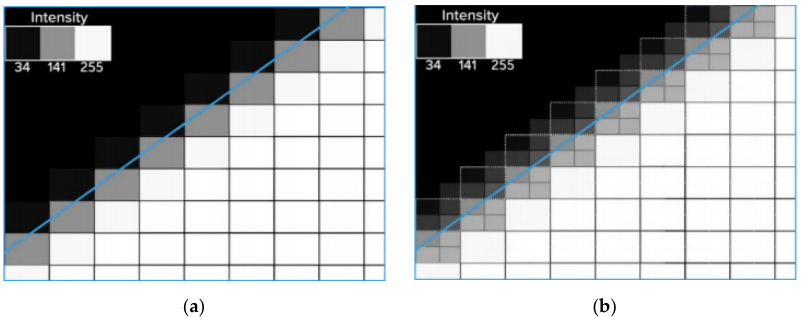
Figure 6. Graphical representation of ( a ) traditional layer-wise stratification and ( b ) DLP anti-aliasing strategy [42].